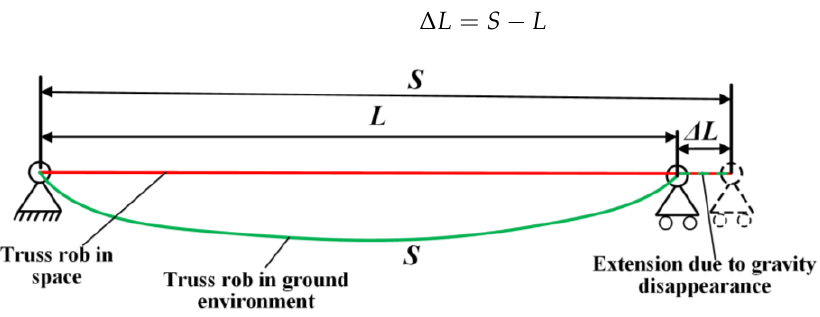
Figure 6. The length of the truss rod in different